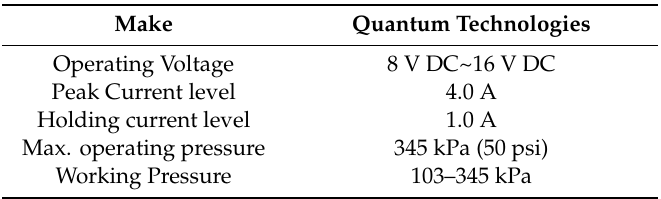
Table 4. Descriptions of the hydrogen